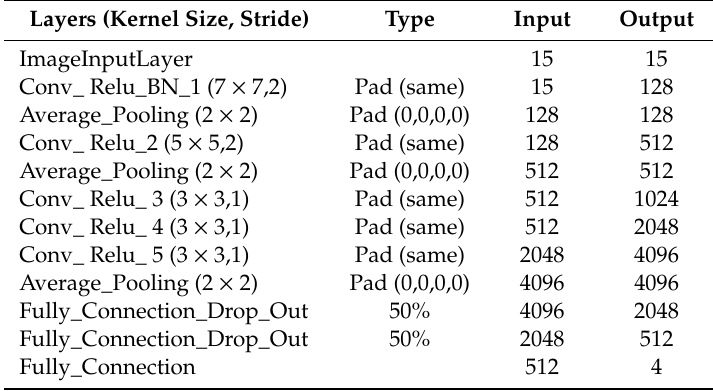
Table 2. General structure of temporal CNN. Pad = padding. BN = batch normalization.